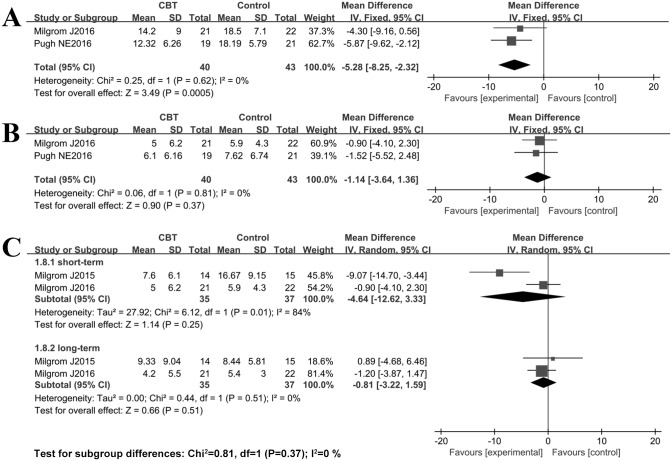
Forest plot of DASS and BAI scores comparing CBT vs. control conditions post-intervention: A random effects analysis.A, DASS-stress; B, DASS-anxiety; C, BAI -anxiety.